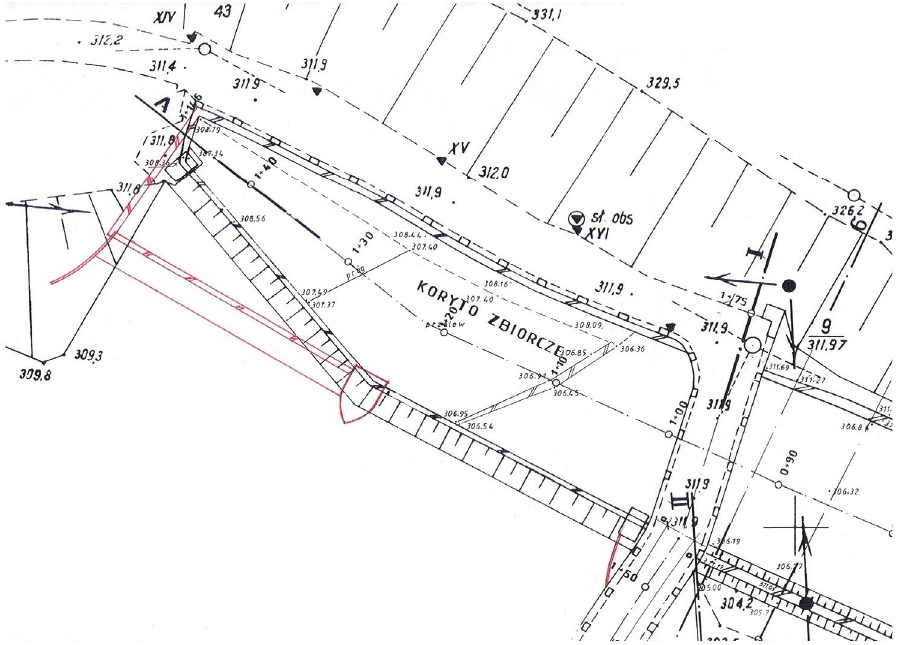
Fig. 6. Proposed reconstruction of the Złotniki reservoir spillway flume